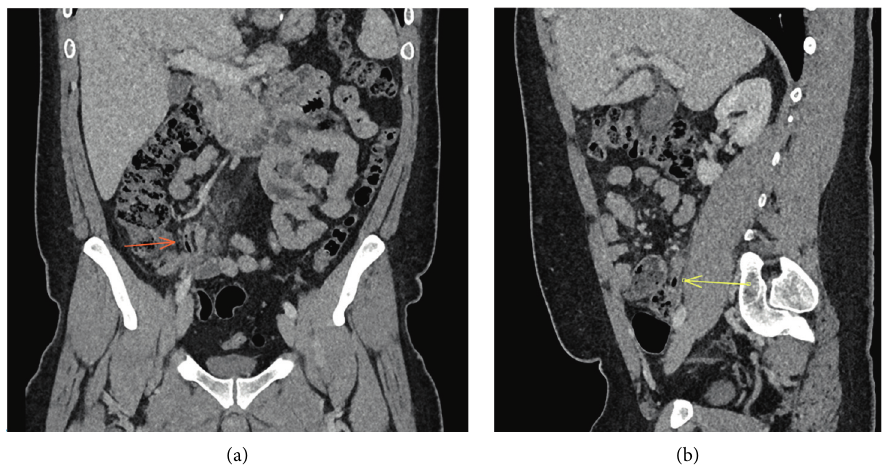
Figure 4: A 33-year-old man with appendiceal intraluminal gas on CT (arrow). Coronal (a) and sagittal (b) CT abdomen in the portal venous phase. The appendix diameter is still within normal limits, but there is low-grade surrounding fat stranding. This is a false-positive